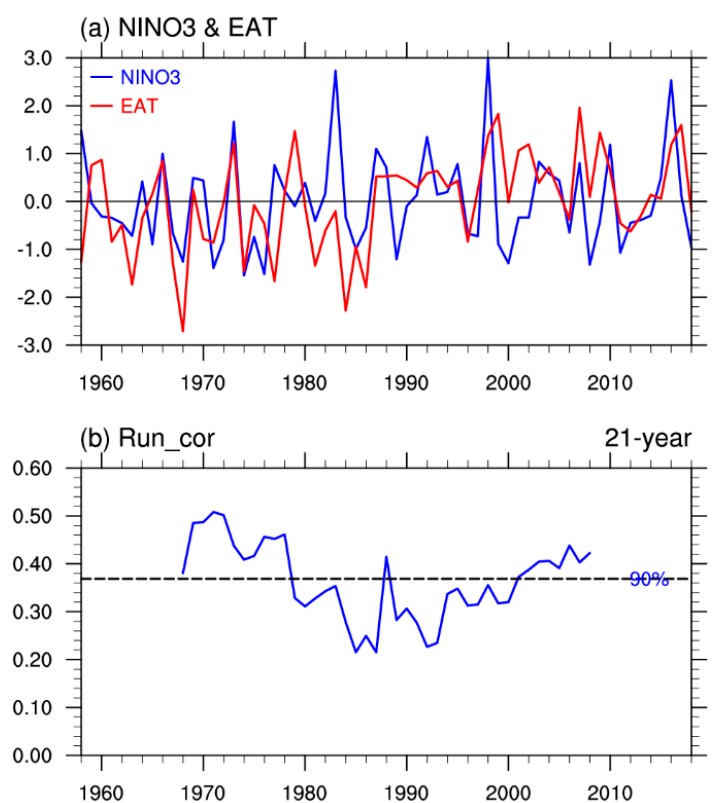
Figure 2. ( a ) Standardized time series of the wintertime Niño-3 index (blue line) and East Asian SAT index (EAT, 20°–40°N, 110°–145°E) during 1958–2018. ( b ) 21 year sliding correlations between the wintertime Niño-3 index and the EAT index. Years in the horizontal axis in ( b ) indicate the central year of the 21 year sliding window. The horizontal black dashed line in ( b ) indicates the correlation coefficient significant at a 90% confidence level.